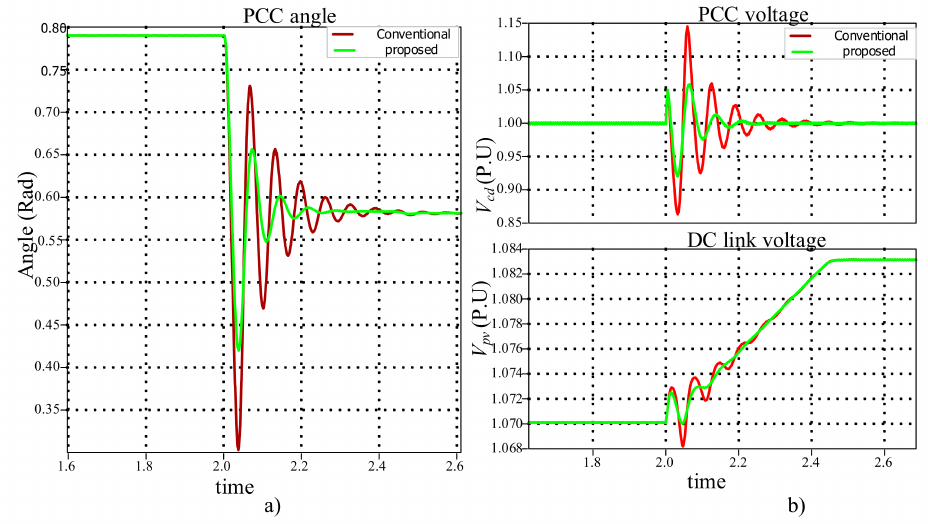
Figure 18. ( a ) PCC voltage angle and ( b ) Vpv and Vcd step change in solar